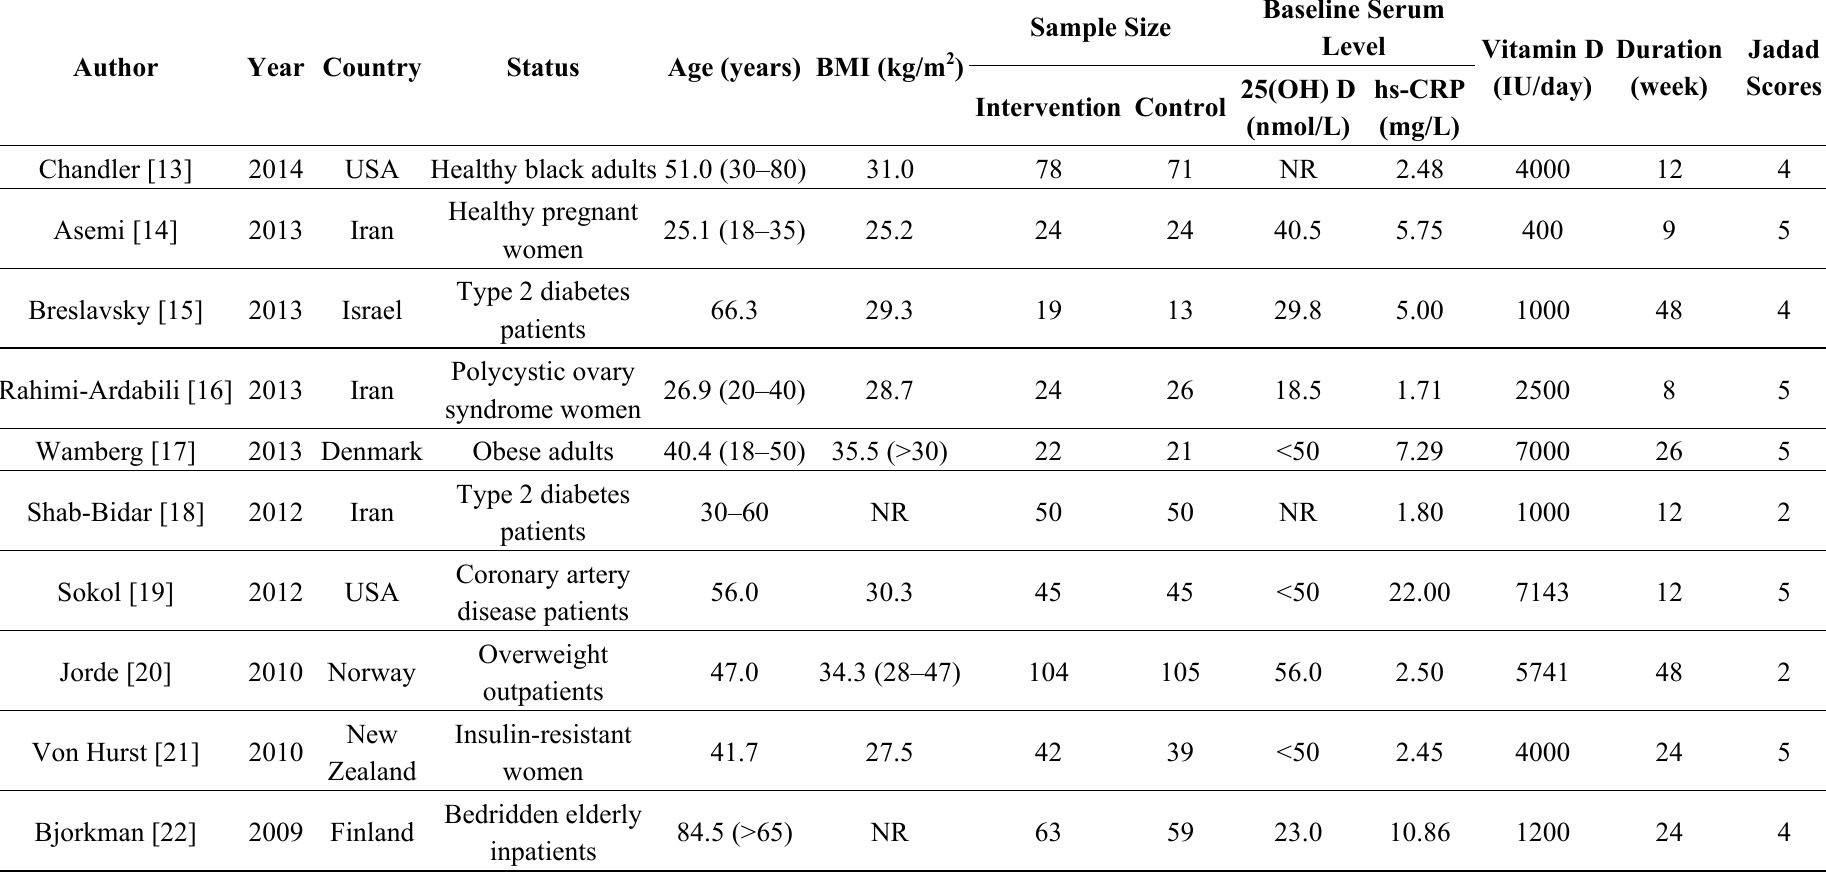
Table 1. Characteristics of randomized controlled trials included in this